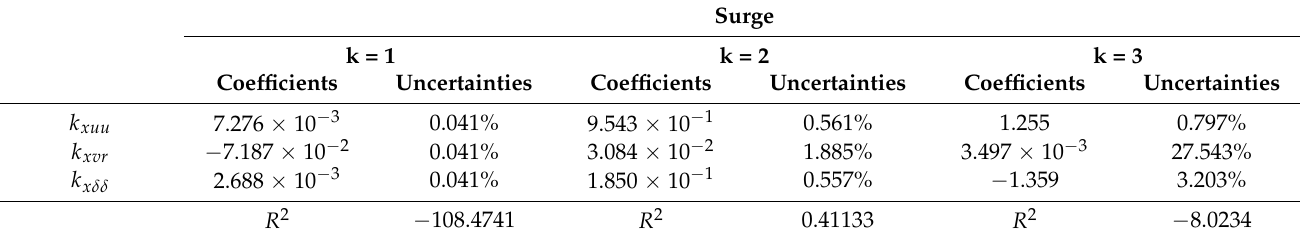
Table 2. Surge adjustment coefficients and uncertainties for simulation of 25 ◦ turning